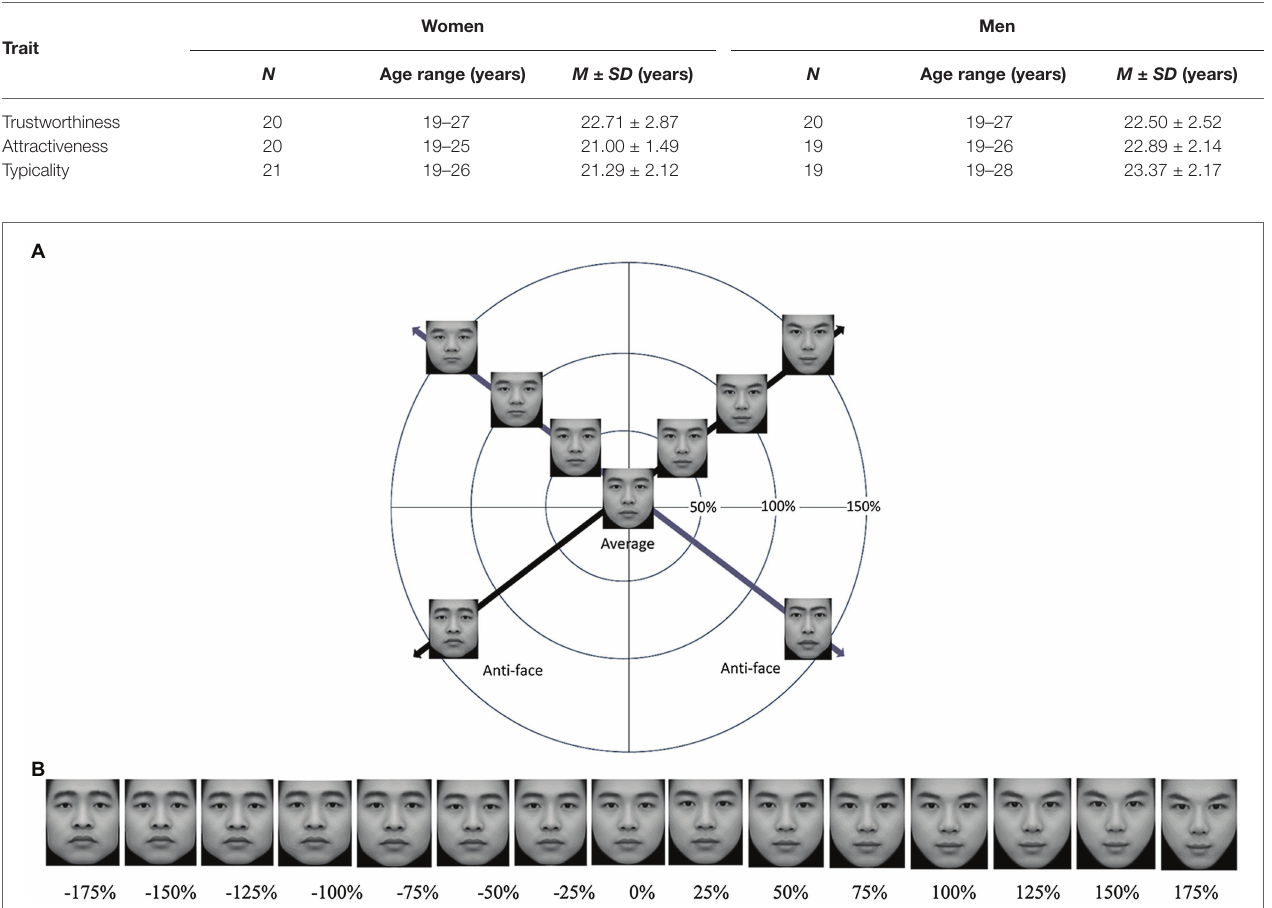
FIGURE 1 | (A) Two face continua through the average face created by morphing 100 faces in a simplified face space. Anti-faces were made by morphing the original face toward and beyond the average face. (B) Example of one entire face continuum. Face transforms were created by adding or subtracting a percentage of the difference in shape between the average and original face. Thus, the average face was at the midpoint of the continuum (DFT = 0%), while the endpoints of the continuum were a caricatured face (DFT = +175%) and its anti-face (DFT = −